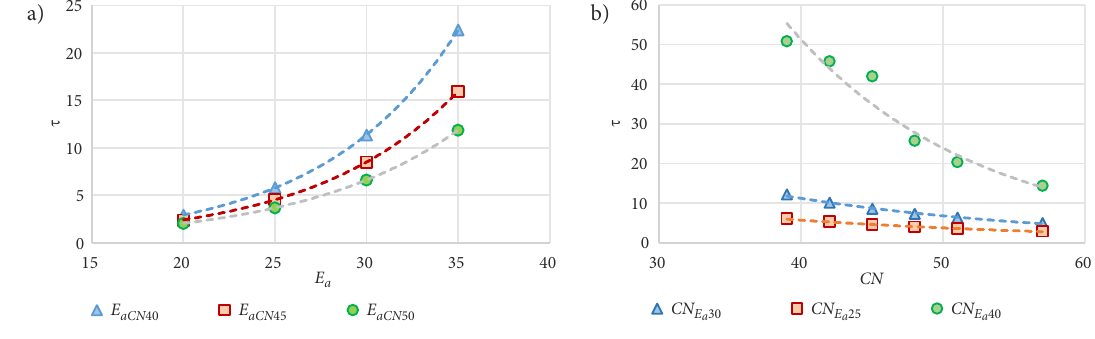
Figure 5. Ignition delay period depending on: a – E a ; b – CN